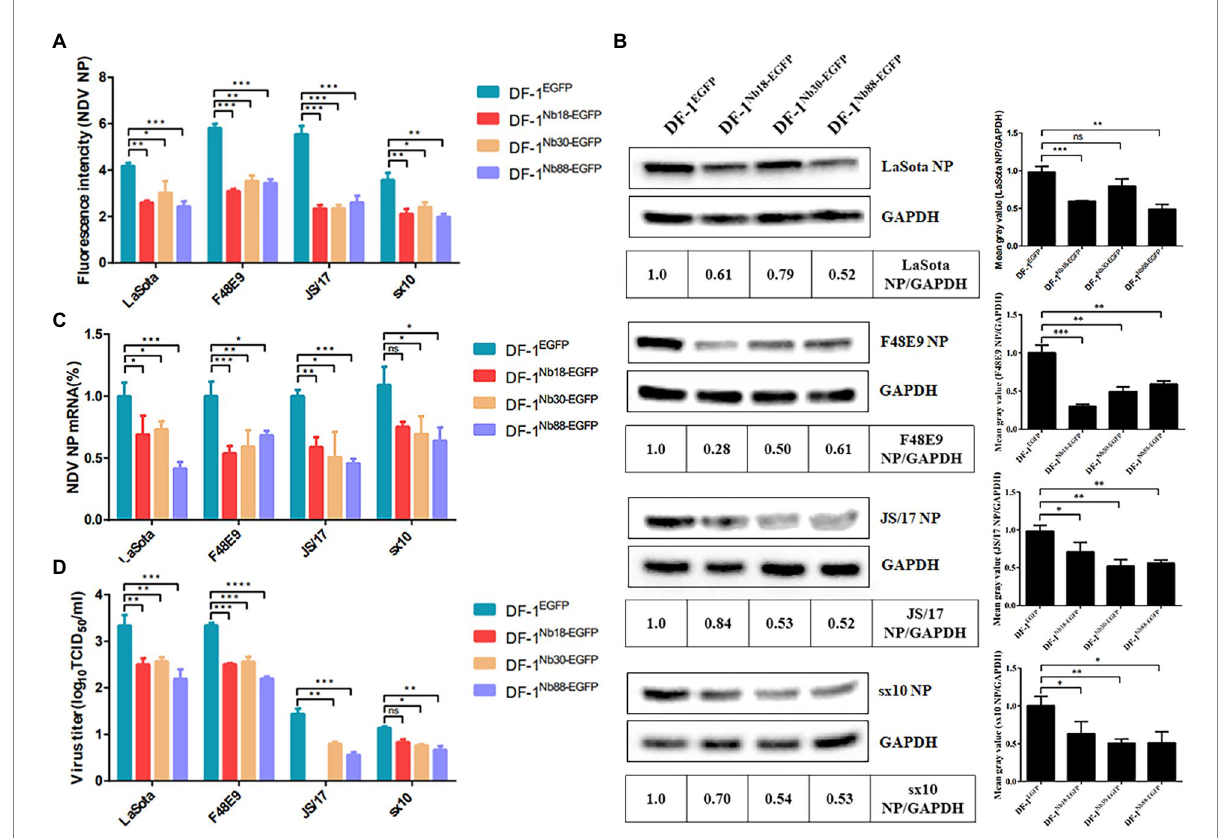
FIGURE 6 Analysis of the four DF1 EGFP , DF1 Nb18-EGFP , DF1 Nb30-EGFP and DF1 Nb88-EGFP cell lines inhibiting the replication of different Class II NDV strains, including LaSota, F48E9, JS/17 and sx10. (A) Mean gray values of indirect immunofluorescence detection of the different NDV strains after infection of the different cell lines are shown. (B) Detection of NDV NP proteins in the four recombinant DF1 cell lines inoculated with LaSota, F48E9, JS/17 and sx10 strains. (C) qRT-PCR to detect the transcription level of the different NDV strains NP protein mRNA in different cell lines. (D) Virus titers (TCID 50 ) derived from the supernatant of the four recombinant DF1 cell lines inoculated with the different NDV strains. The results were performed in triplicate and data are presented as the mean ± the SD. * p < 0.05; ** p < 0.01; *** p < 0.005 (two-tailed Student’s t -test).